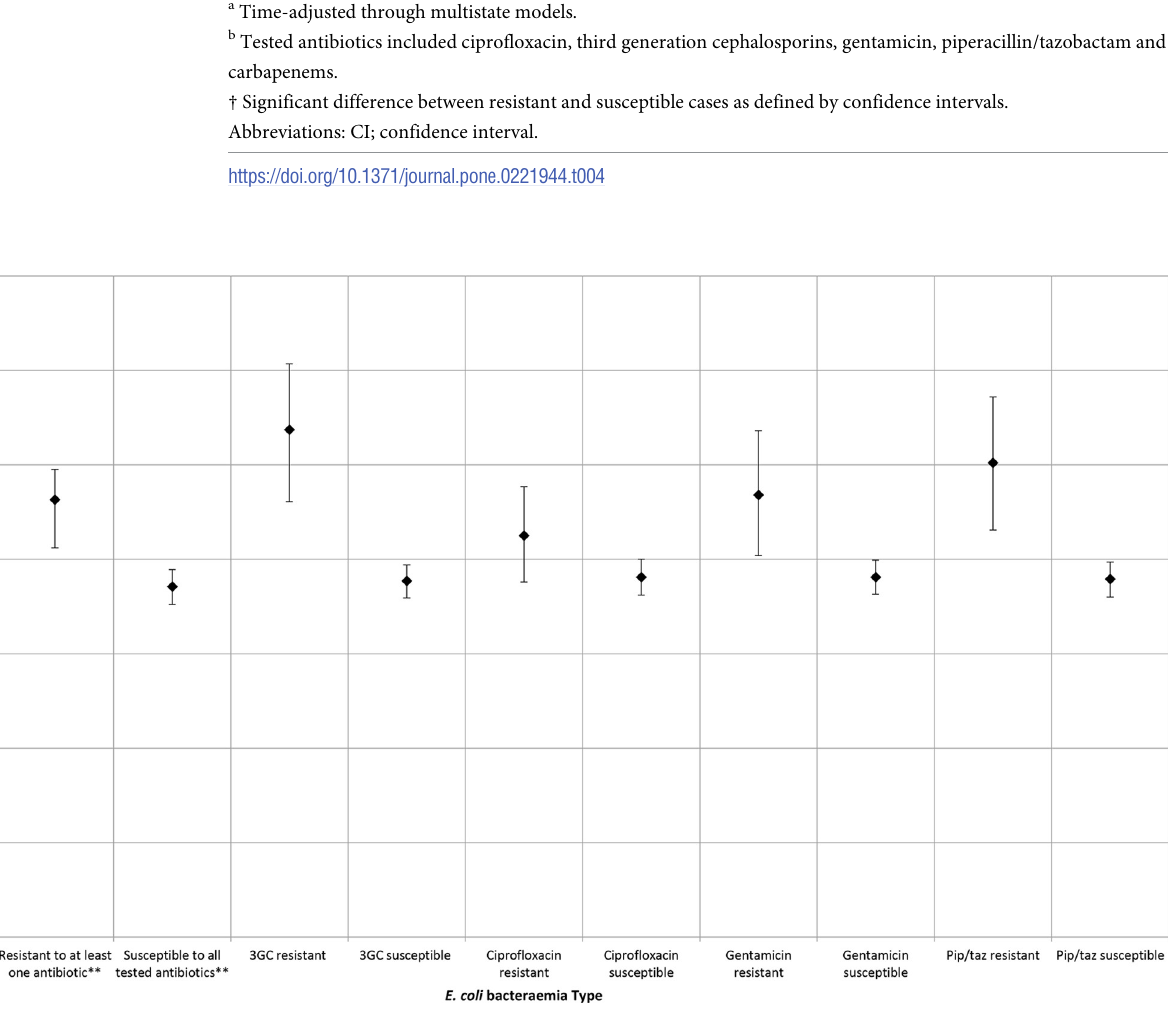
PLOS ONE | https://doi.org/10.1371/journal.pone.0221944 September 10,